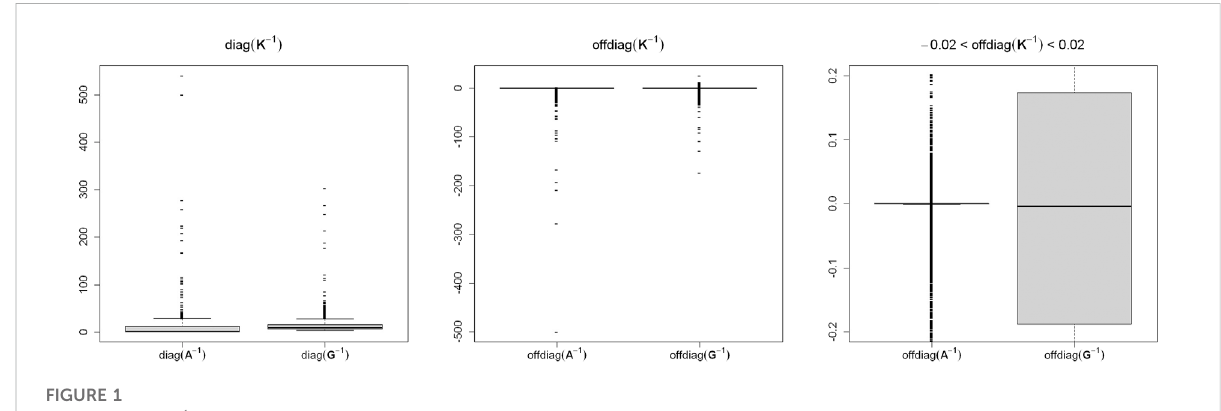
FIGURE 1 Distribution of K − 1 elements for the wheat